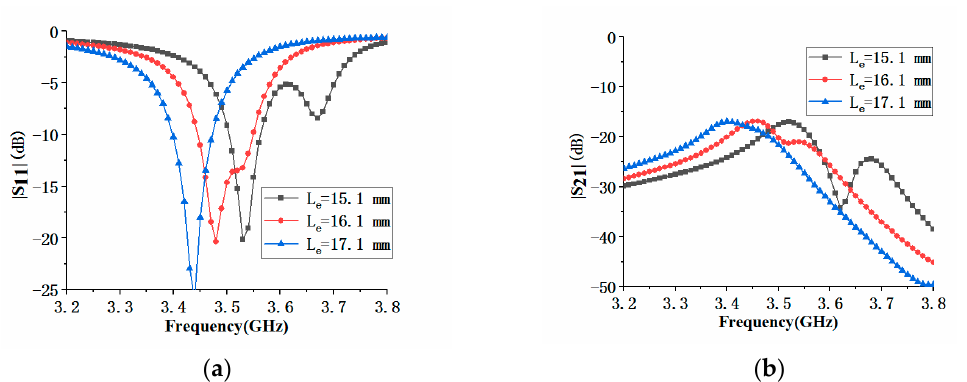
Figure 18. Comparison of |S 11 | and isolation of the proposed antenna with different antenna parameter L e : (a) |S 11 | comparison; (b) |S 21 | comparison.